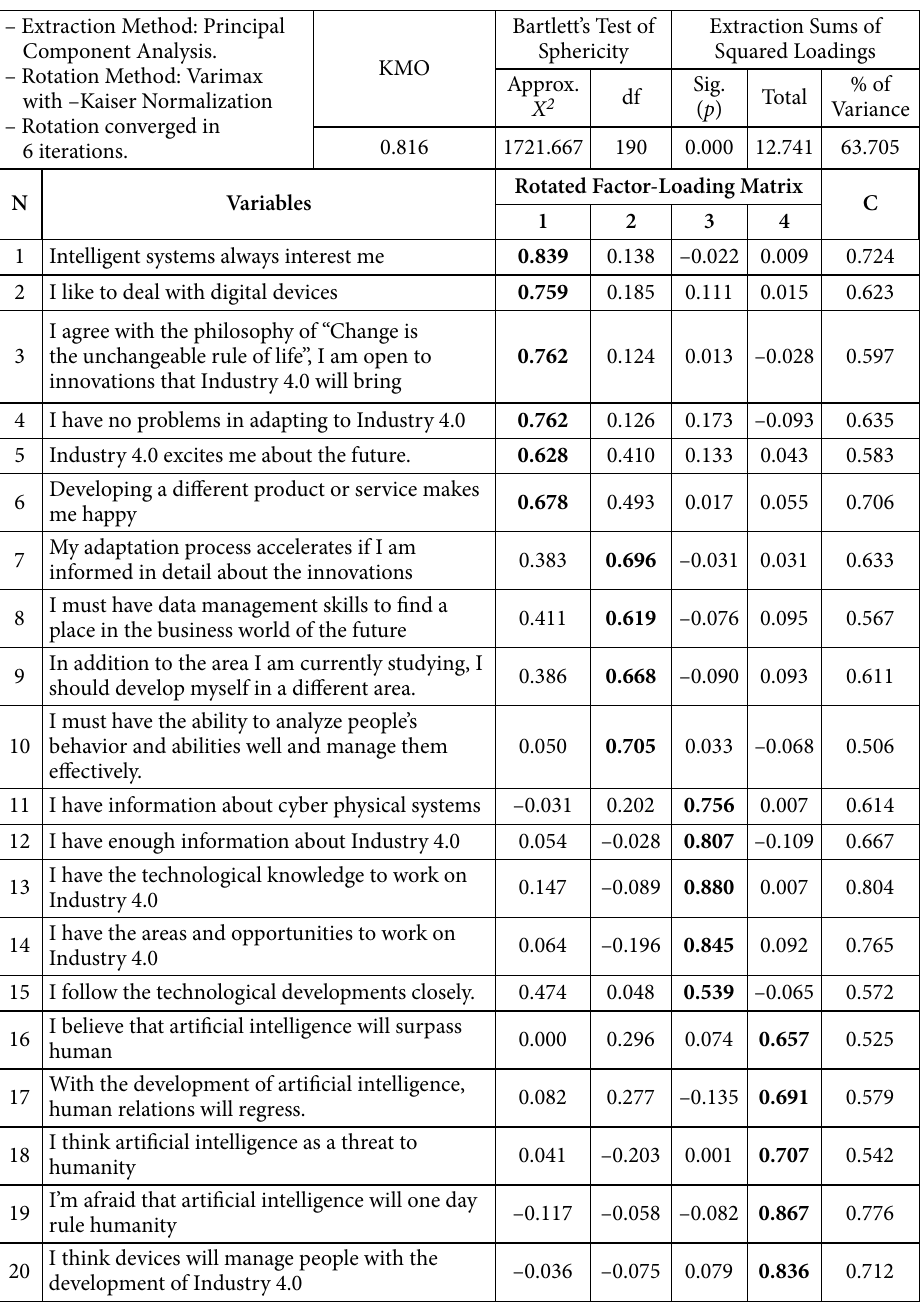
Table 6. Factor analysis